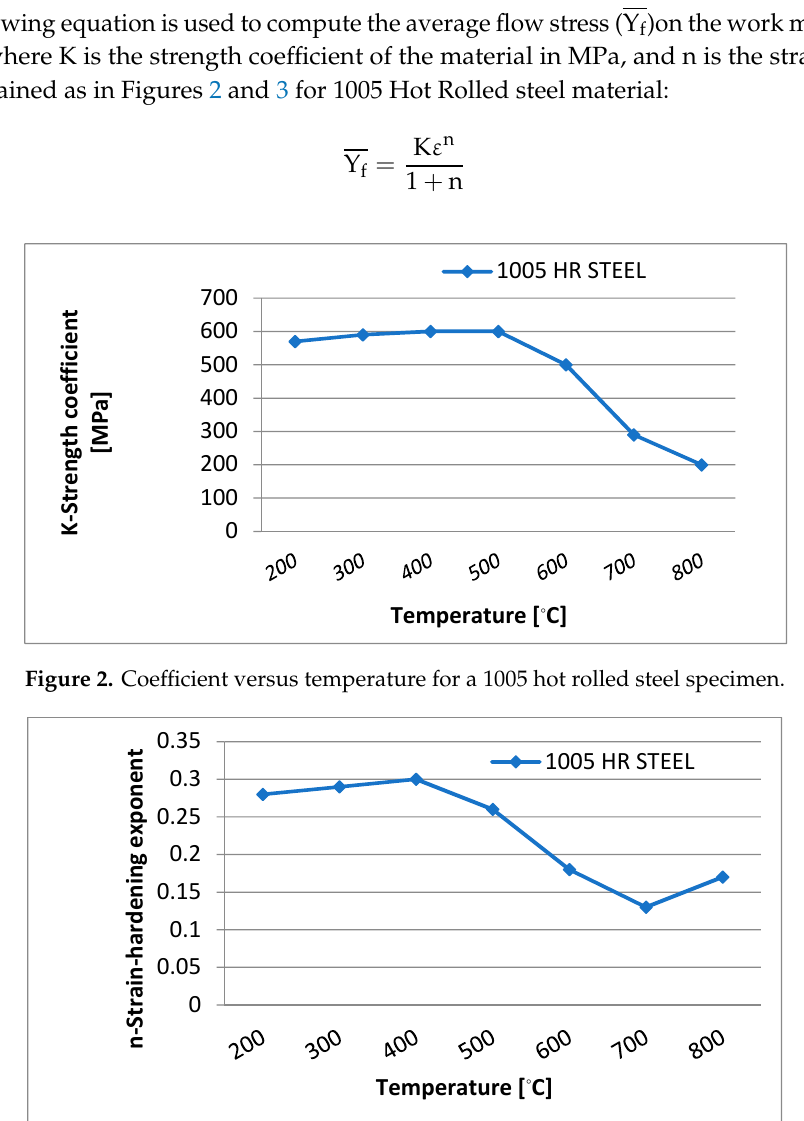
Figure 3. Exponent versus temperature for a 1005 hot rolled steel specimen.